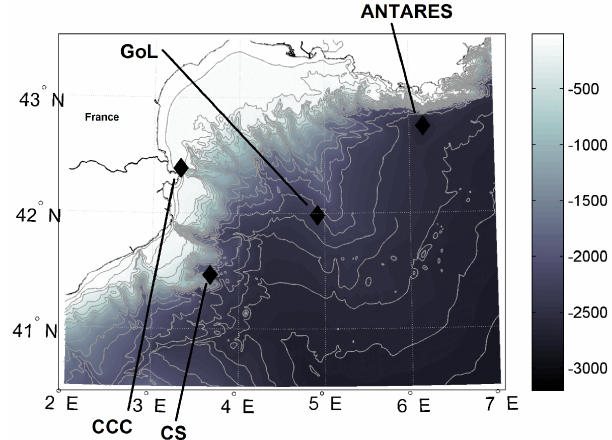
Fig. 5. Location of the four monitoring sites in the north-western Mediterranean (CCC=Cap de Creus 39 Canyon; CS=Catalan slope; GoL=Gulf of Lion, at the centre of the offshore DWF area; ANTARES=ANTARES